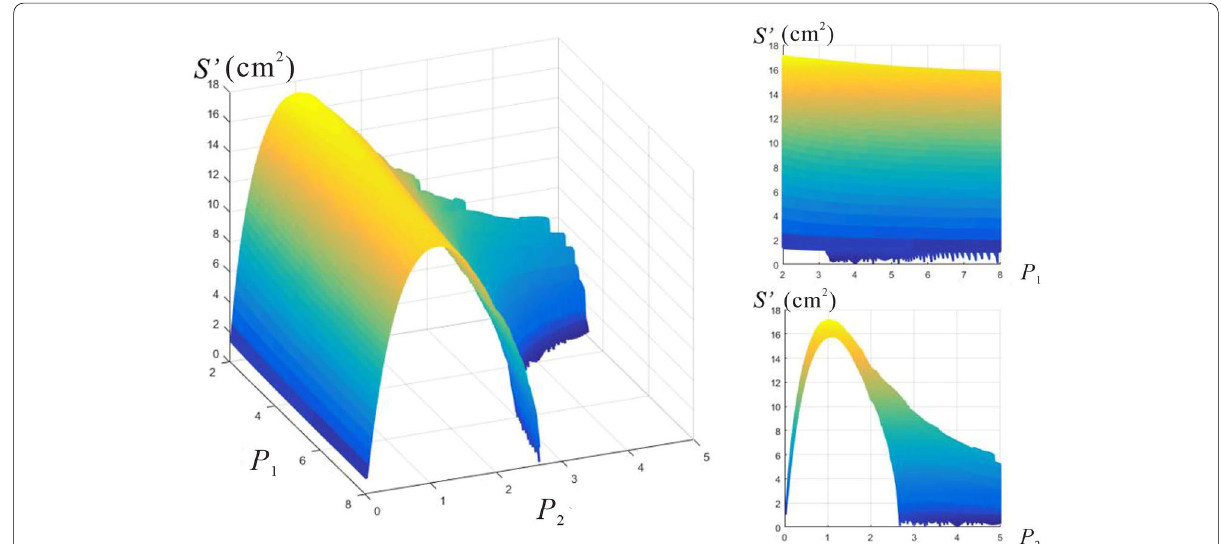
Figure 9 Results of the S ′ of the symmetrical palm workspace